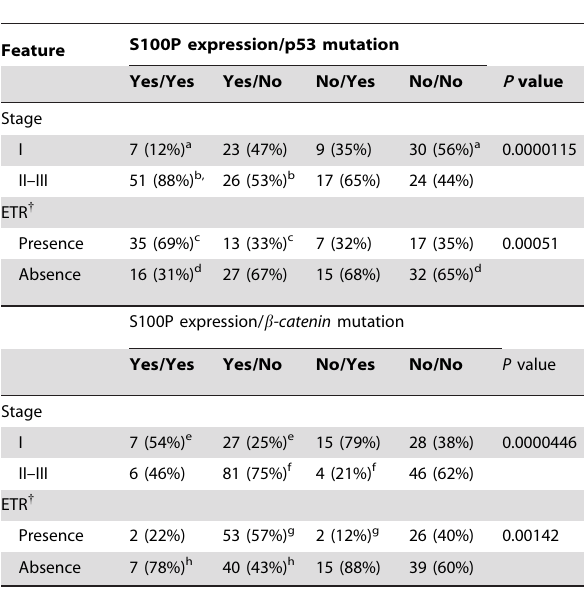
Table 4. Interaction between S100P expression with p53 mutation or b -catenin mutation in the tumor progression of hepatocellular